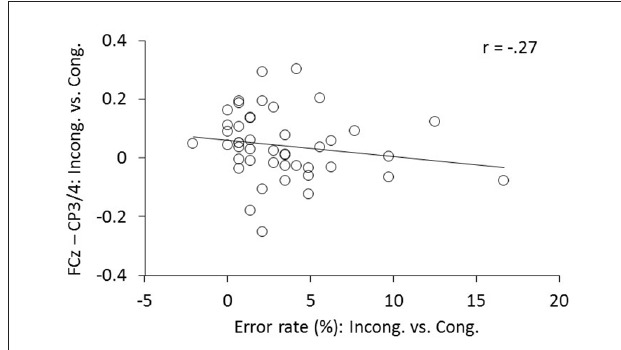
FIGURE 8 | The relationship between the changes in FCz-CP3/4 synchrony and ER. Individual changes of ICPSs (ln[incongruent] − ln[congruent]) shows corresponding changes in ERs (incongruent −